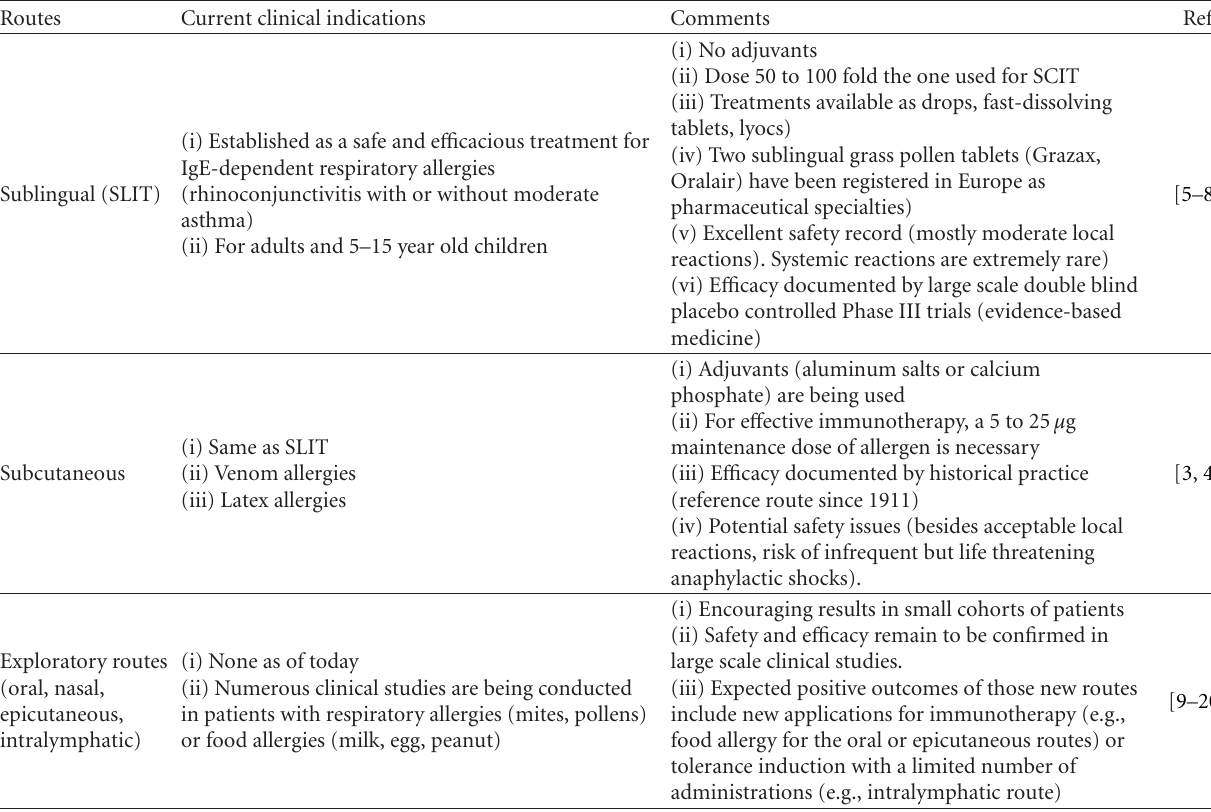
Table 1: Compared characteristics of sublingual versus other administration routes for allergy